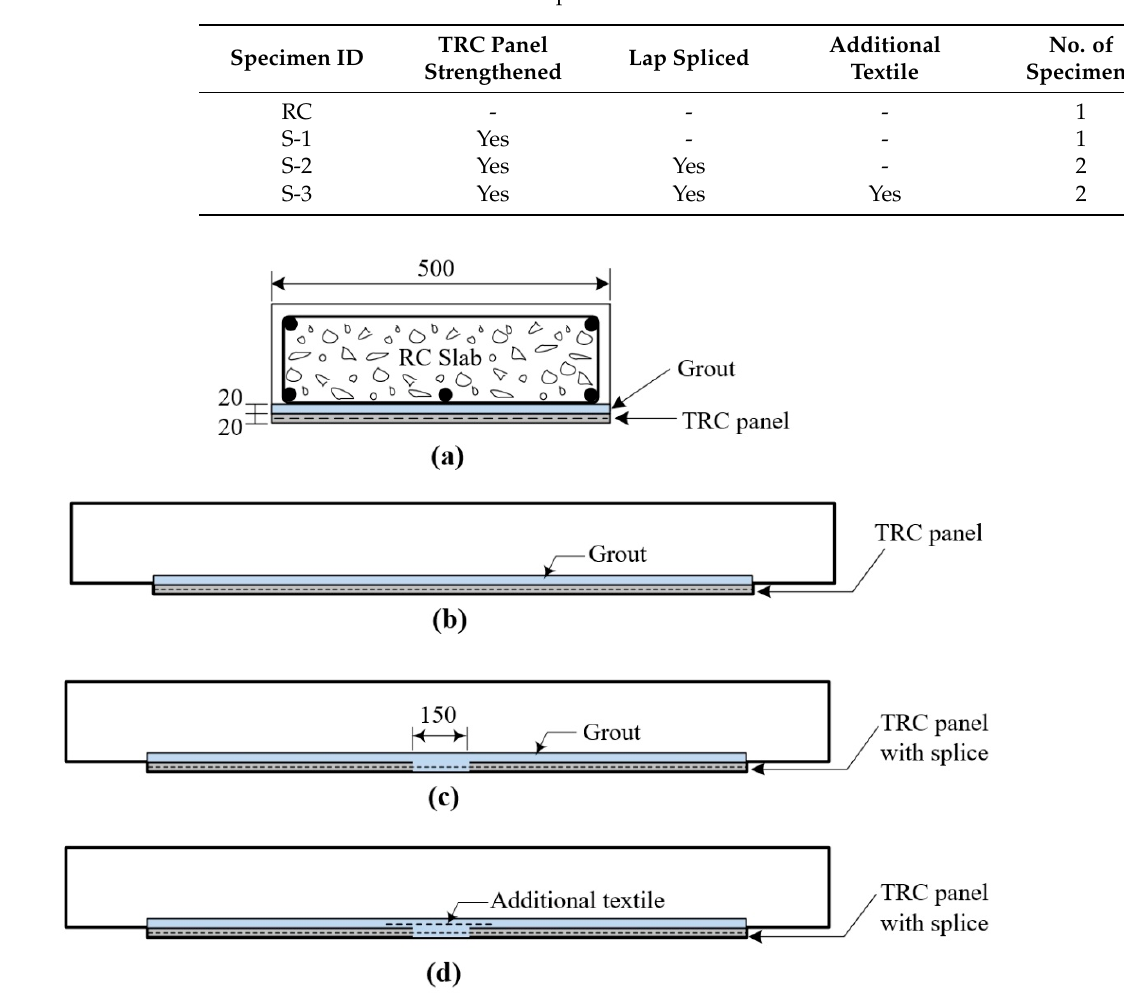
Figure 9. RC slab specimen: ( a ) cross-sectional dimensions; ( b ) reinforcement details; ( c ) side view of RC specimen; side view of RC slab to be strengthened with TRC panel; and ( d ) side view of RC slab with indented space.